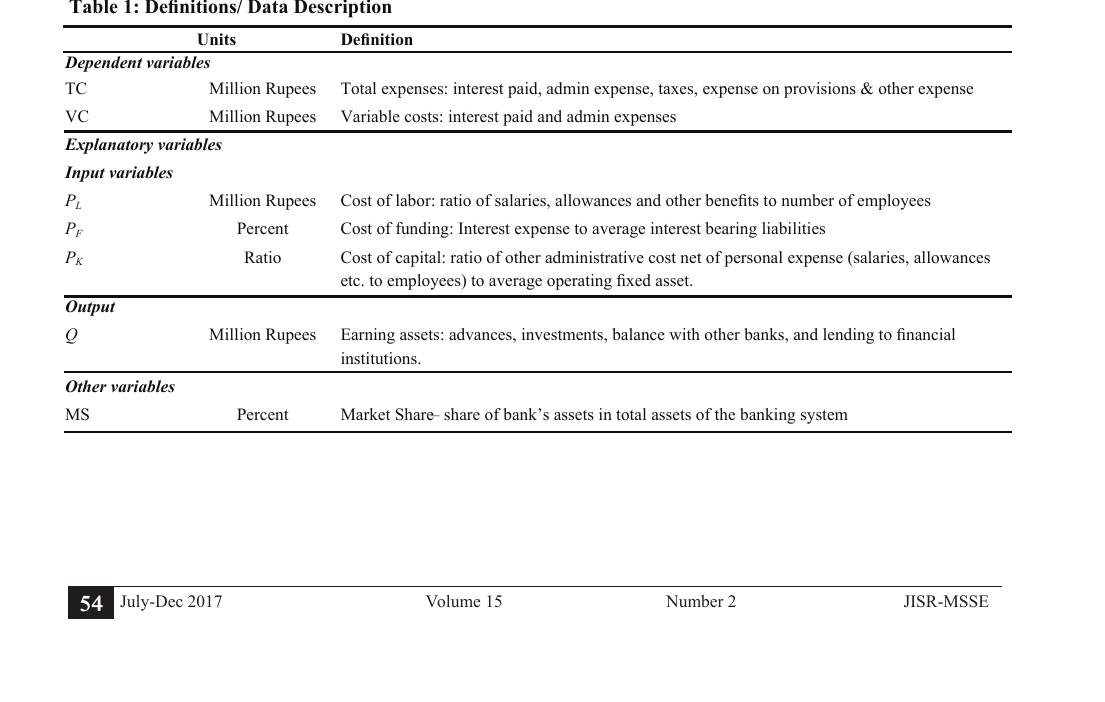
Table 1: Definitions/ Data